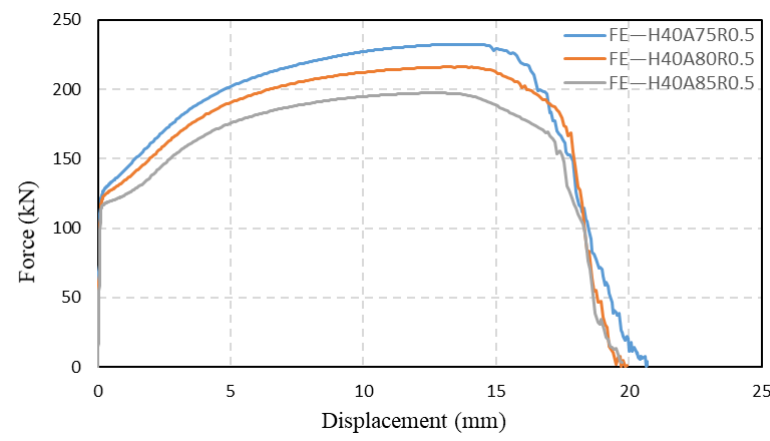
ff ect of concave angle on load–displacement curves. Appl. Sci. 2020 , 10 , x FOR PEER REVIEW